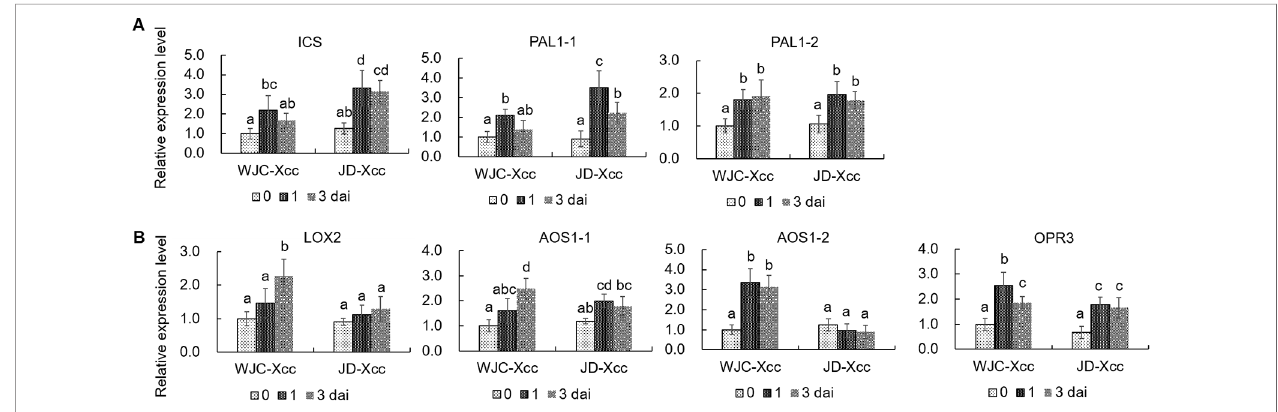
FIGURE 3 | Transcriptional levels of genes involved in the synthesis of SA and JA. (A) Expression levels of genes involved in SA synthesis. (B) Transcriptional levels of genes involved in JA synthesis. Leaves from Wanjincheng orange (S) and Jindan (R) were injected with canker pathogen Xcc in solution. qRT-PCR was used to assess the expression levels of genes before and at 1 or 3 days after inoculation. Error bars represent the SDs of three biological replicates. Different letters above bars represent signi fi cant differences from the 0 dai of WJC-Xcc based on Duncan ’ s multiple range test ( P < 0.05). WJC, Wanjincheng orange; JD, Jindan; dai, days after inoculation; Xcc, Xanthomonas citri ssp. citri ; ICS, isochorismate synthase; PAL, phenylalanine ammonia lyase; LOX, 13-lipoxygenases; AOS, 13-allene oxide synthase; OPR3, 12-oxophytodienoate reductase